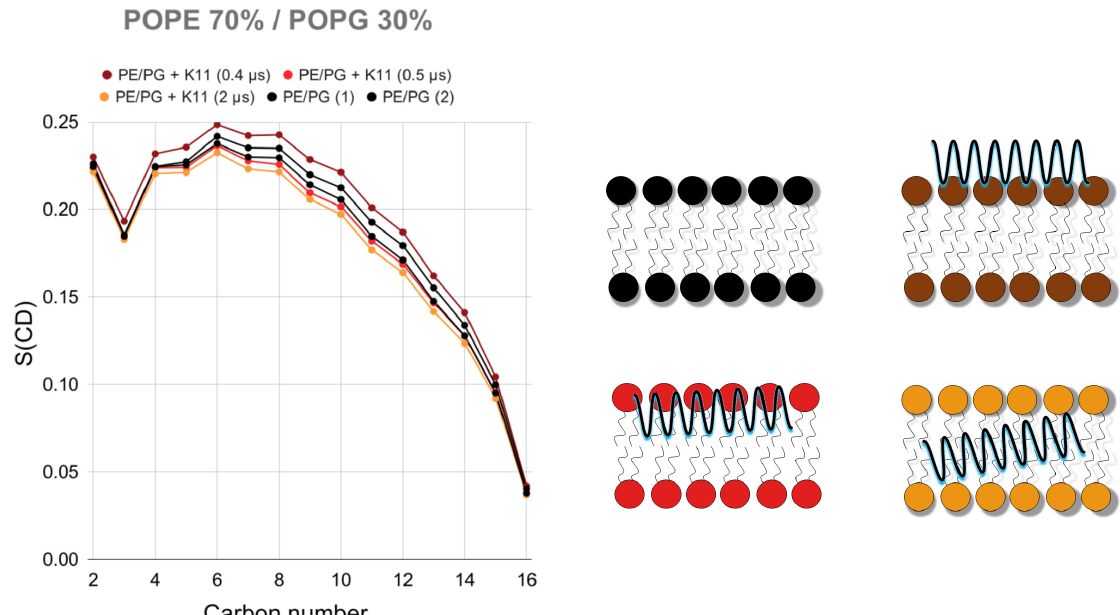
Figure 6. Order parameter of C-H moieties in palmitoyl side chains in membranes containing POPE (70%) and POPG (30%) as calculated from MD simulations in the absence (2 repetitions in black labeled as 1 and 2) and in the presence of K11 peptide. The order parameter varies in different ways along the 2 μ s trajectory. The membrane is rigidified upon interaction (brown curve) but becomes more fluid as the peptide penetrates (red) and becomes internalized (orange curve).